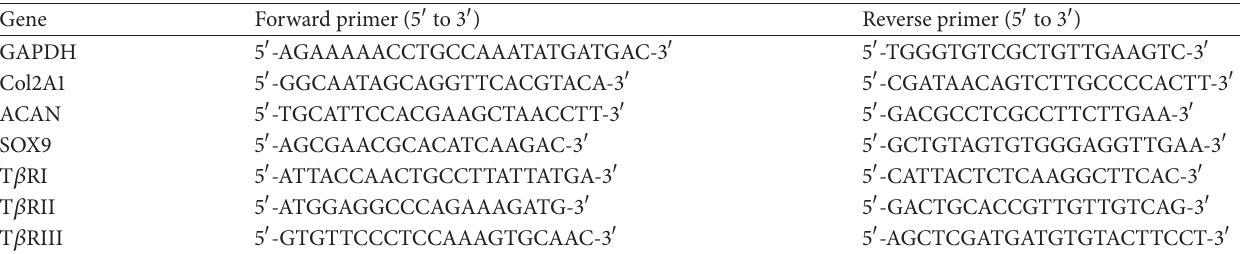
Table 1: Primers used for real-time